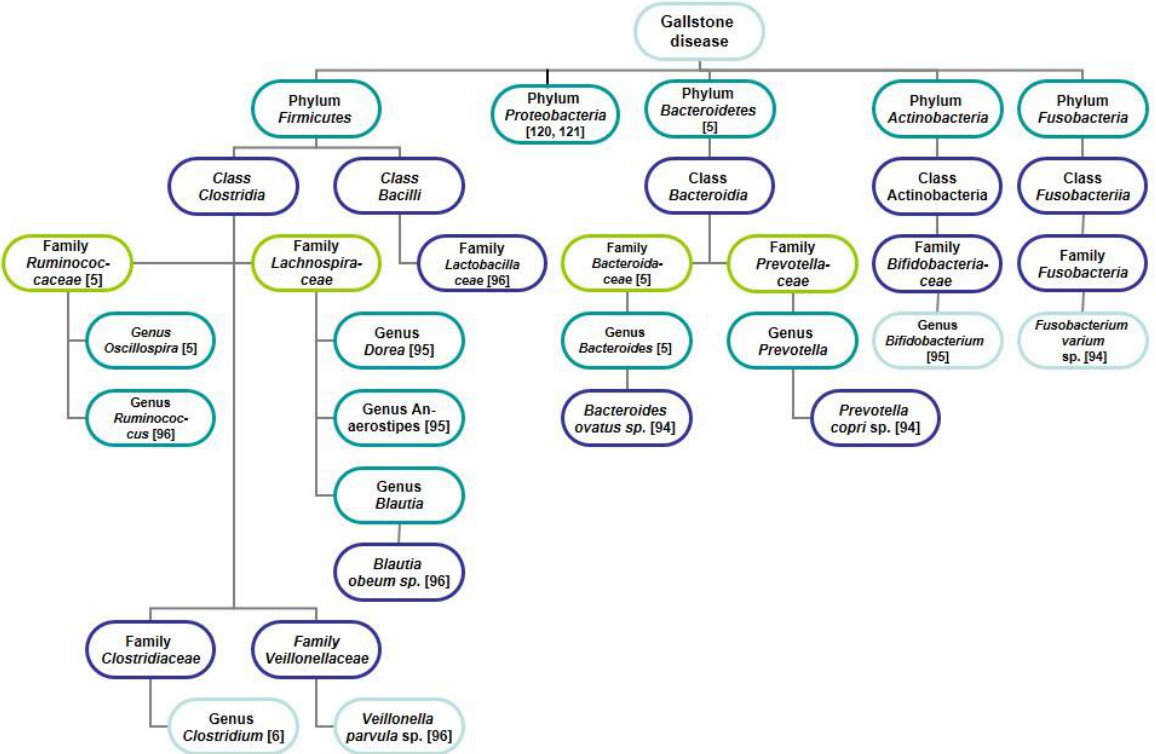
Figure 1. Characteristics of the gut microbiome of patients with GSD. A significant increase of the phyla Firmicutes , Actinobacteria , Proteobacteria , and Bacteroidetes is reflected. The number in square brackets indicates a reference in the list of